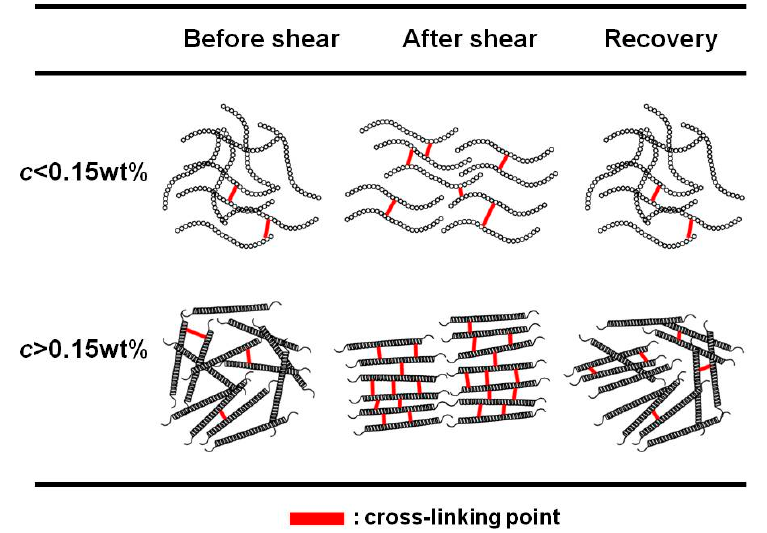
Figure 9. Schematic illustrations representing the rheopectic behavior for sacran aqueous solutions.